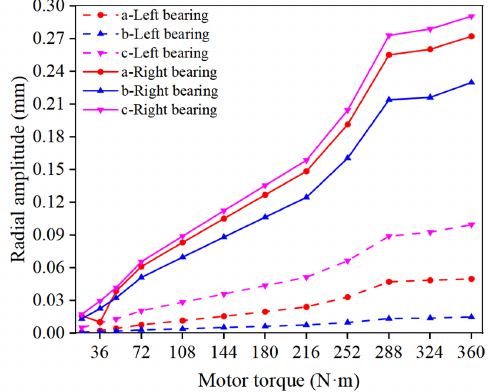
Figure 9. Radial amplitude of outer ring of bearing.